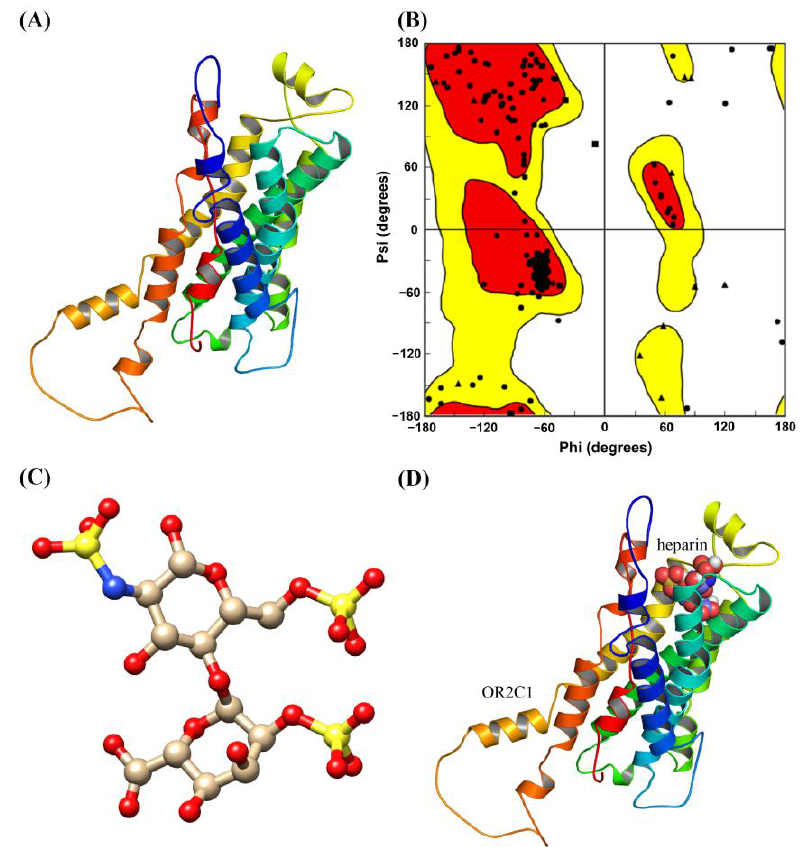
Figure 2. Homology modelling and molecular docking of OR2C1 and heparin. ( A ) Homology model of OR2C1 protein; ( B ) Ramachandran plot of OR2C1 protein (the Ramachandran plot is mainly divided into three areas: allowed area (red area), maximum allowed area (yellow area), and not allowed area (blank area)); ( C ) Structure of heparin; ( D ) The predicted binding model of OR2C1 and heparin.